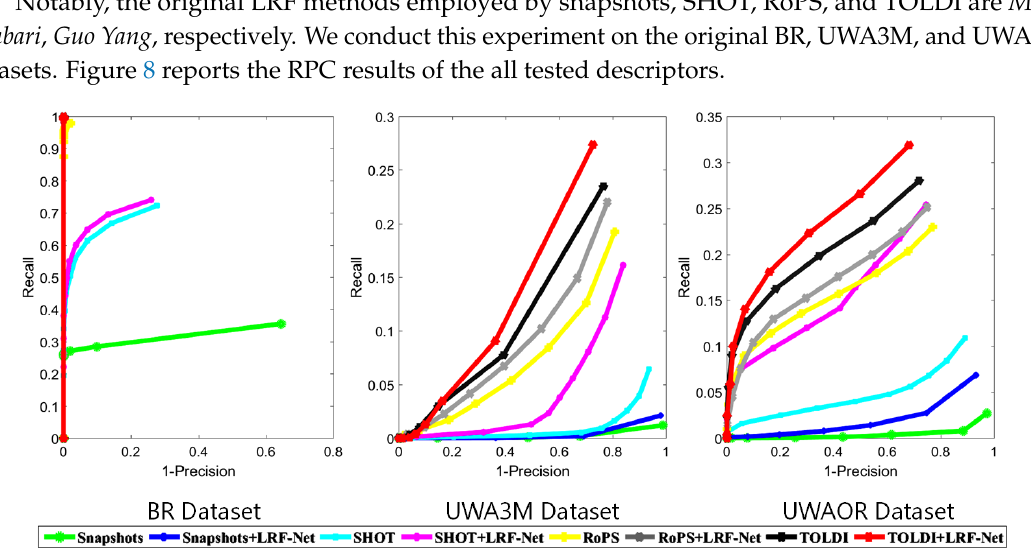
Figure 8. Local shape description performance of LRF-based descriptors with LRF-Net and their original LRFs on the BR, UWA3M, and UWAOR datasets.